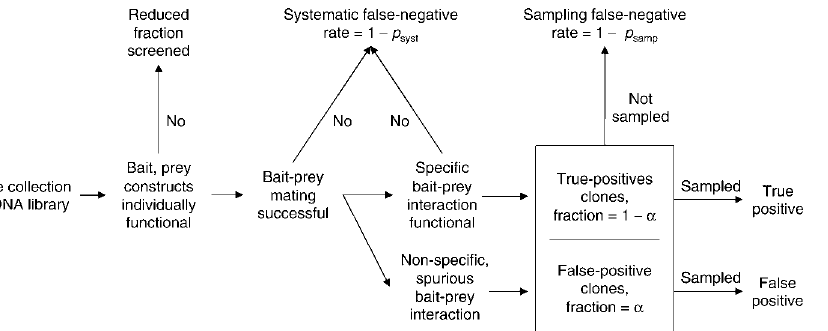
Figure 1. Flowchart for Yeast Two-Hybrid Screens Indicates Systematic and Stochastic Sources of False Negatives and Stochastic Sources of False